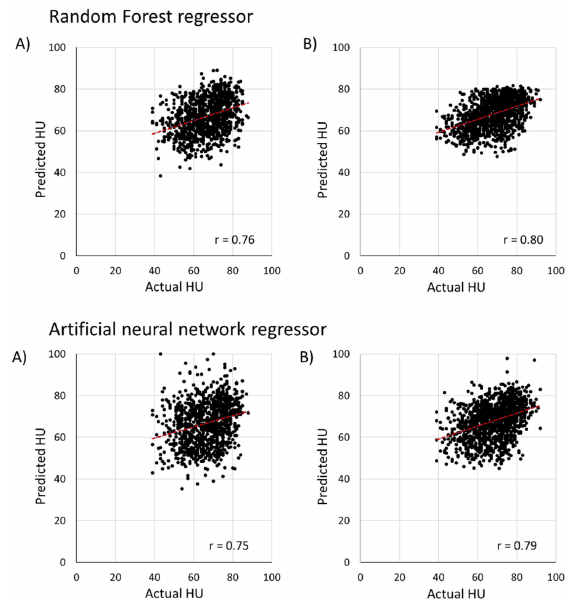
Figure 10. The result of general machine learning (RF and ANN regressor) for predicting HU using temperature data: ( A ) the results without data augmentation for random forest and artificial neural network regressor; ( B ) represents the results with data augmentation for random forest and artificial neural network regressor.